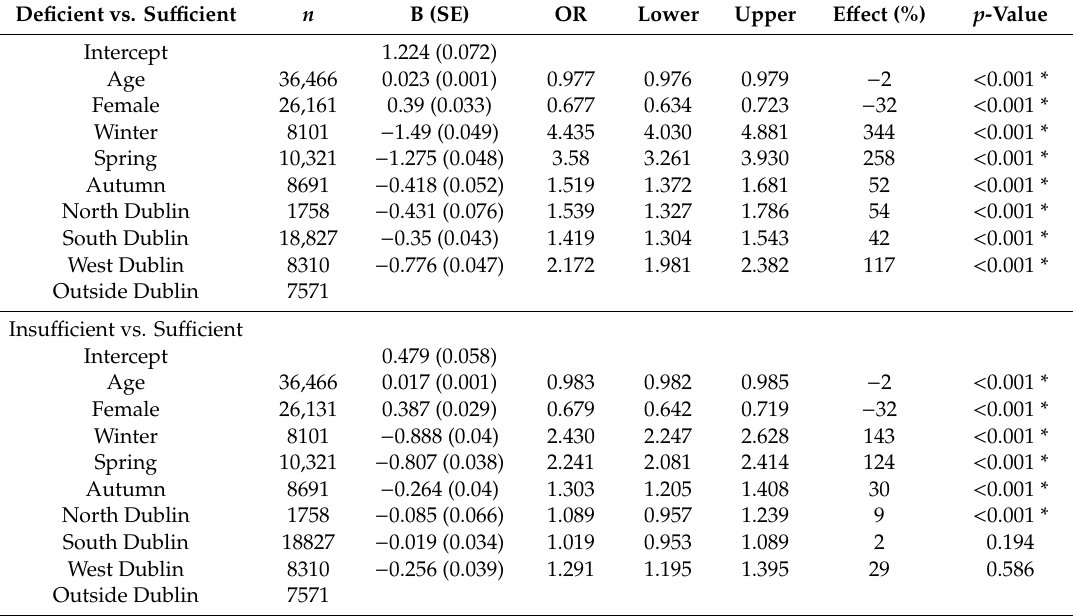
Table 6. Predictors of vitamin D deficiency < 30 nmol / L) and insu ffi ciency (30–49 nmol / L) in multinomial regression. Deficient vs. Su ffi cient